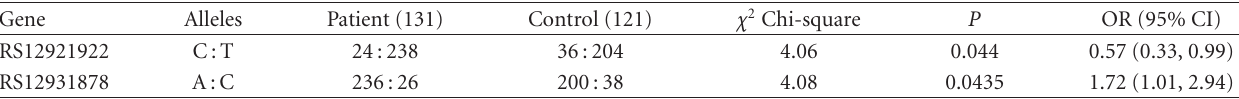
Table 2: Frequency distribution of the alleles at the two loci of the CLEC16A gene with statistical significance in Chinese children with TIDM and healthy control groups.